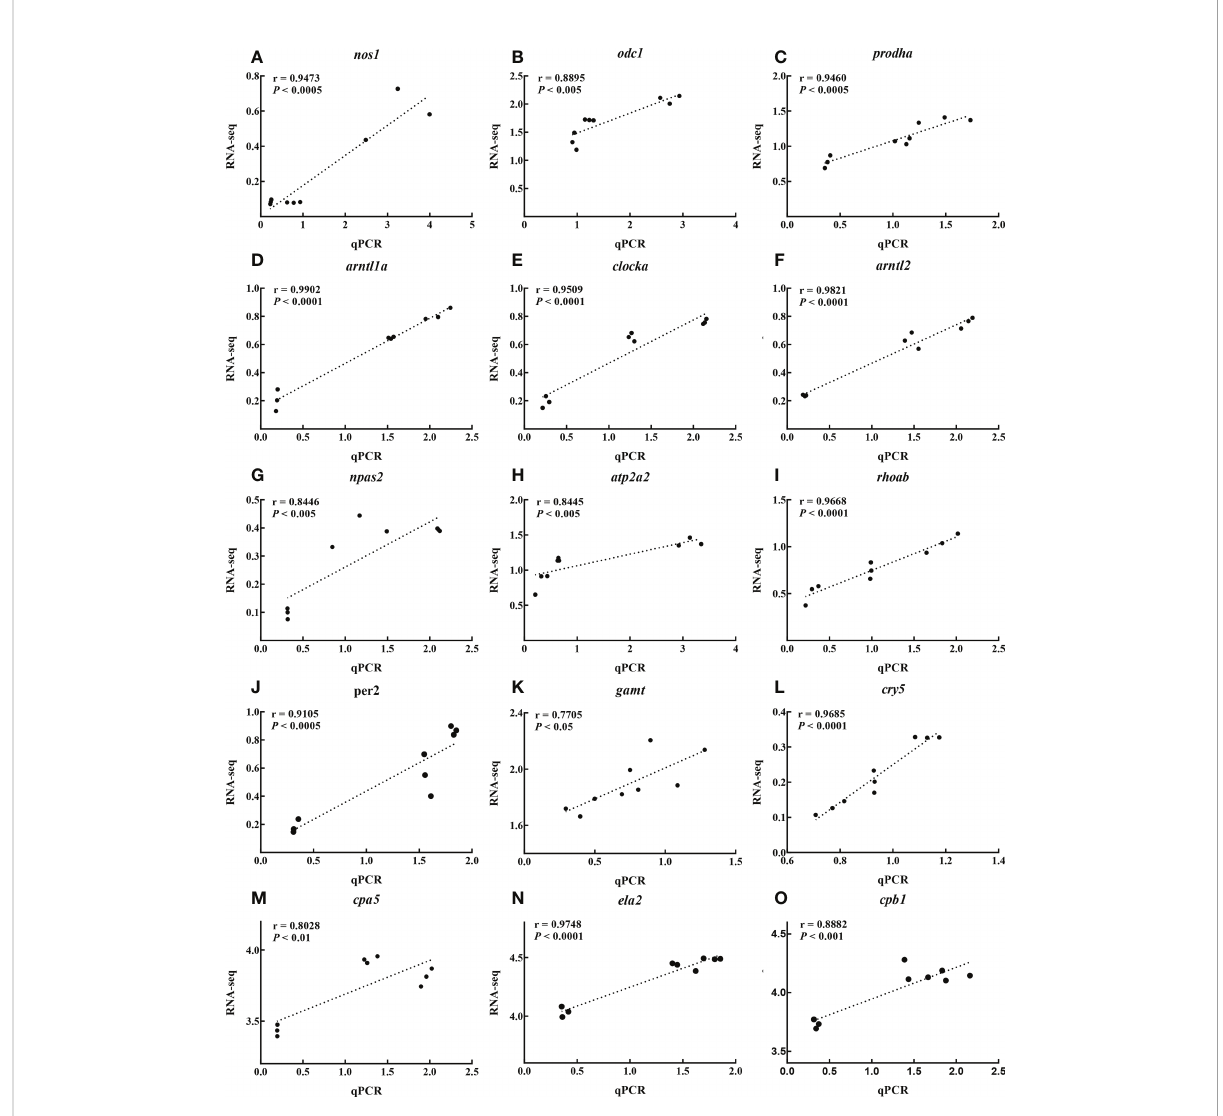
FIGURE 6 Scatter plot of correlation between RNA-seq and qPCR results of nos1 (A) , odc1 (B) , prodha (C) , arntl1a (D) , clocka (E) , arntl2 (F) , npas2 (G) , atp2a2 (H) , rhoab (I) , per2 (J) , gamt (K) , cry5 (L) , cpa5 (M) , ela2 (N) and cpb1 (O) under different temperature.